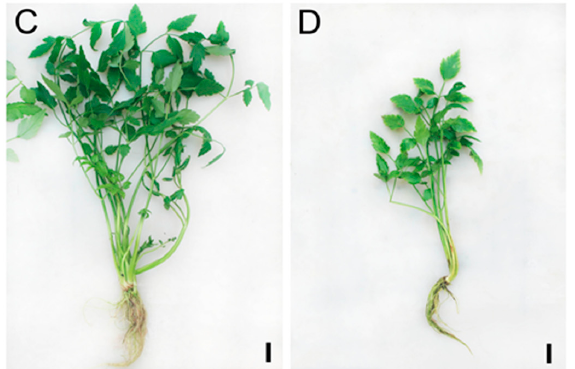
Figure 1. E ff ect of salt stress on phenotype of water dropwort ( A ) V11E0135 control (0 mmol / L NaCl), Figure 1. Effect of salt stress on phenotype of water dropwort A ) V11E0135 control (0 mmol/L NaCl), ( B ) V11E0135 treated (200 mmol / L NaCl), ( C ) V11E0022 control (0 mmol / L NaCl), and ( D ) V11E0022 samples. Values are means ± SD. B ) V11E0135 treated (200 mmol/L NaCl), C ) V11E0022 control (0 mmol/L NaCl), and D ) V11E0022 treated (200 mmol / L NaCl). Bars = 1 cm. treated (200 mmol/L NaCl). Bars = 1 cm. Table 1. Effect of salt stress on phenotypic parameters and biomass of two cultivars of the water dropwort.